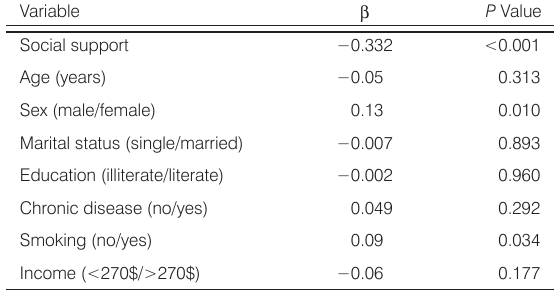
Table 6. Associations between SCL-90 total score and social support and demographic variables in multivariate linear